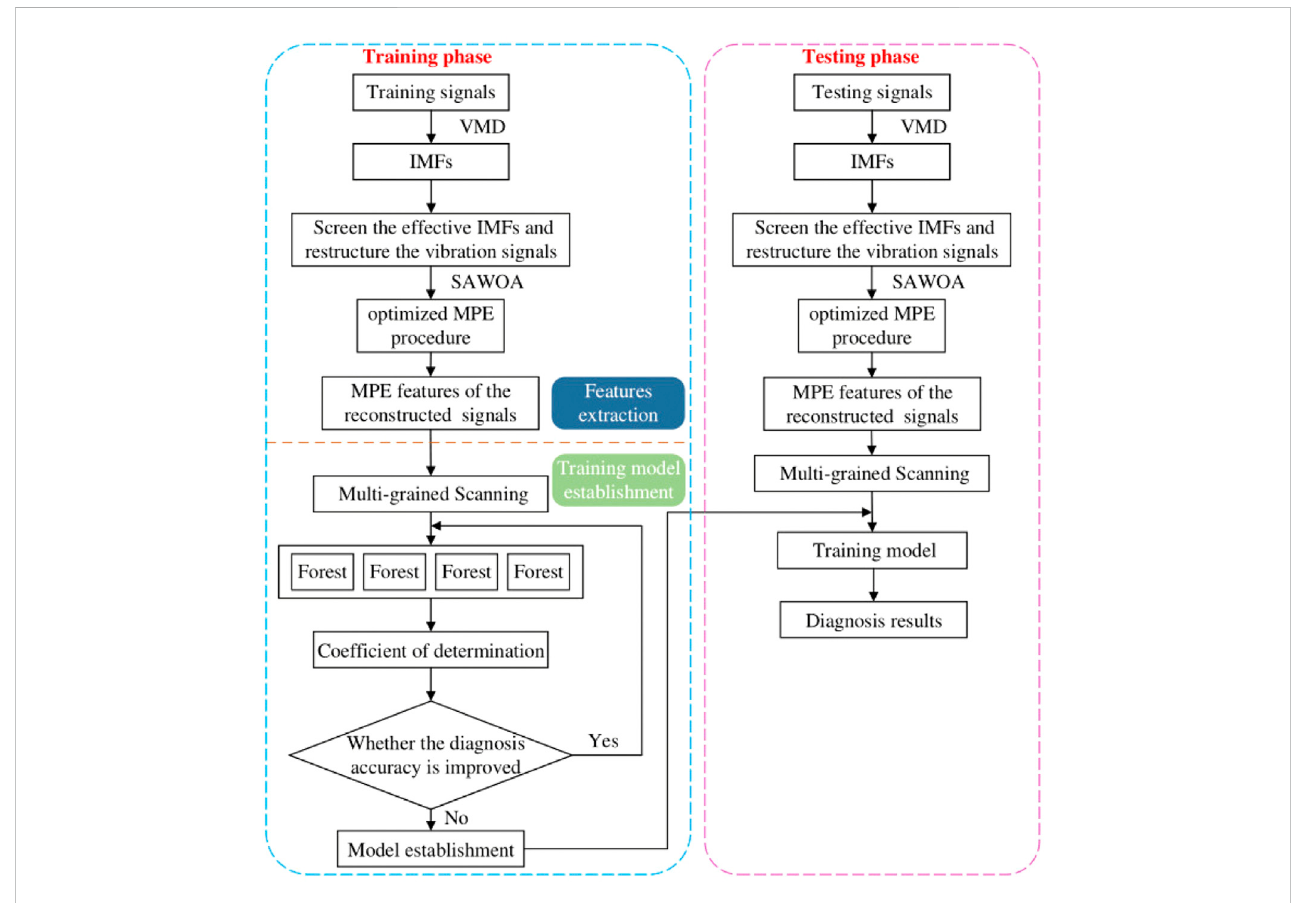
FIGURE 4 Flow chart of the proposed fault diagnosis